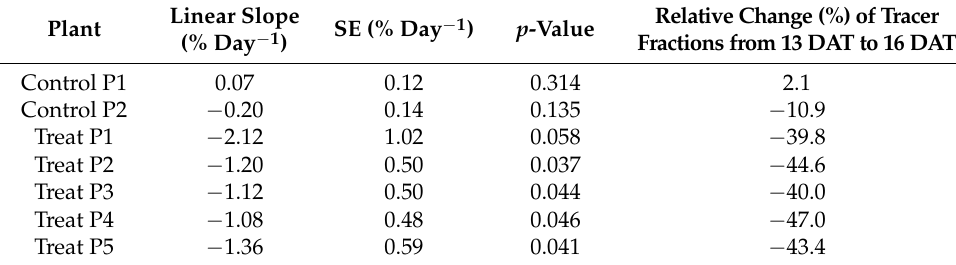
Table 1. Relative change (%) of tracer fractions over the duration of the experiment. Relative Change (%) of Tracer Linear Slope SE (% Day − 1 ) p -Value Plant Fractions from 13 DAT to 16 DAT (% Day − 1 ) Control P1 0.07 0.12 0.314 2.1 Control P2 − 0.20 0.14 0.135 − 10.9 Treat P1 − 2.12 1.02 0.058 − 39.8 Treat P2 − 1.20 0.50 0.037 − 44.6 Treat P3 − 1.12 0.50 0.044 − 40.0 Treat P4 − 1.08 0.48 0.046 − 47.0 Treat P5 − 1.36 0.59 0.041 −